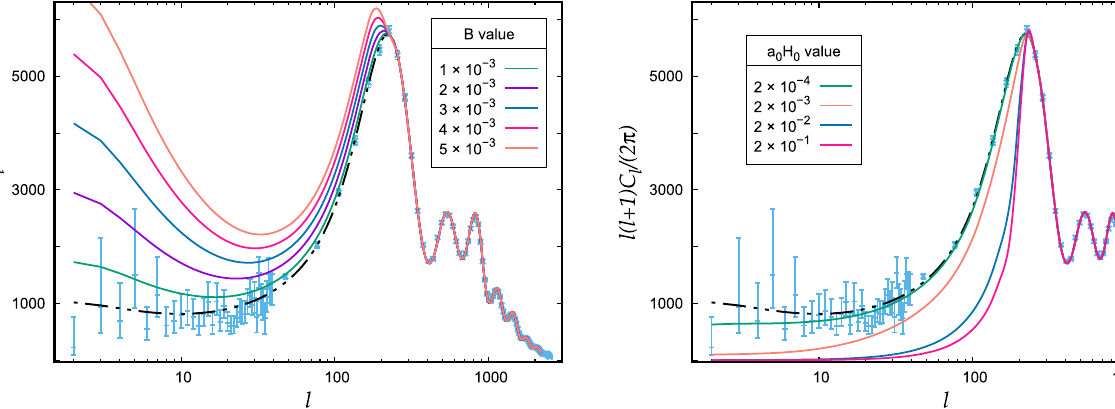
Fig. 3 Exploring a wide range of B values clearly shows that not any value would fit observational data (even when our model mostly affects the lowest multipoles, which are masked by the cosmic variance). Dif- ferent B values of order 10 − 3 are tested, fixing a 0 H 0 = 2 × 10 − 4 . The solid line represents the prediction from the CSL model (exact for- mula). The dashed black line depicts the prediction from the canonical model . Increasing the value of B shows a progressive departure from the standard prediction and the data. This implies an excess in the CMB angular power spectrum anisotropies